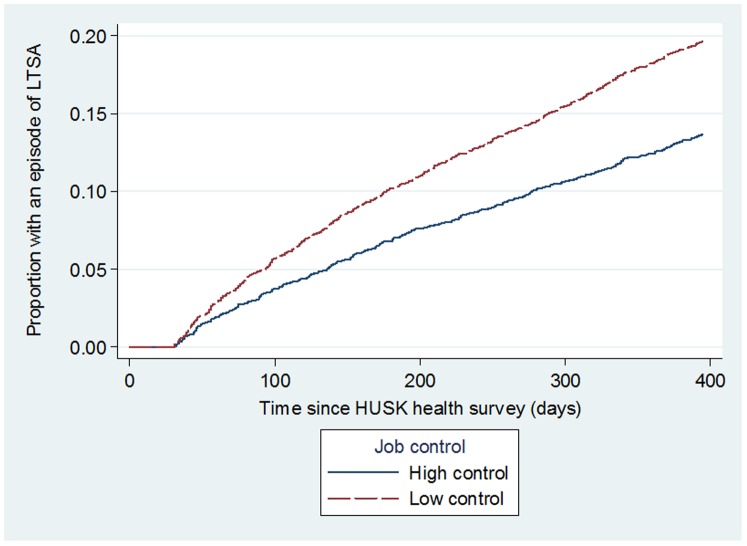
Unadjusted risk of participants having an episode of long term sickness absence (LTSA) by job control.